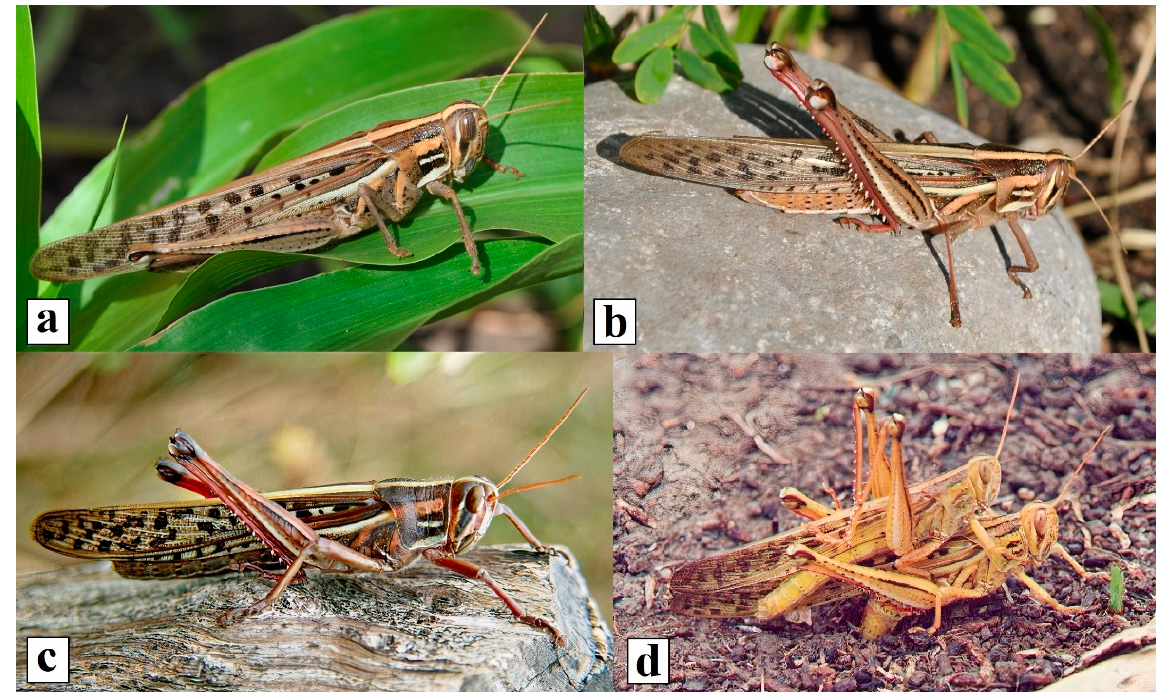
Figure 5. Central American locust, Schistocerca piceifrons piceifrons (Walker, 1870), sexually immature adults in the solitarious ( a , b ) and gregarious phase ( c ); sexually mature adult in gregarious phase showing bright yellow color ( d ).